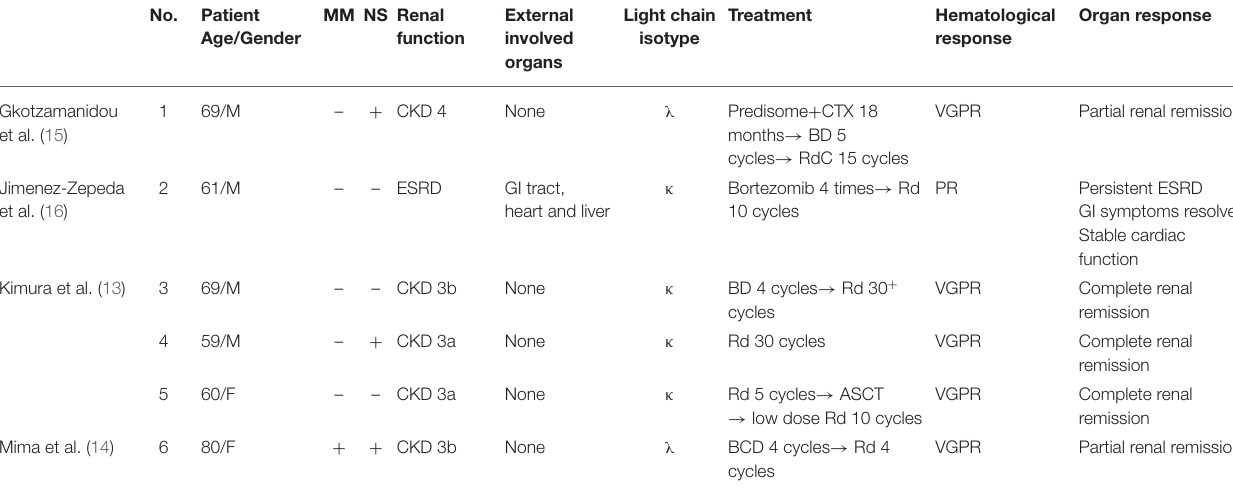
TABLE 1 | Reported cases of LCDD treated with lenalidomide. No. Patient MM NS Renal Age/Gender function